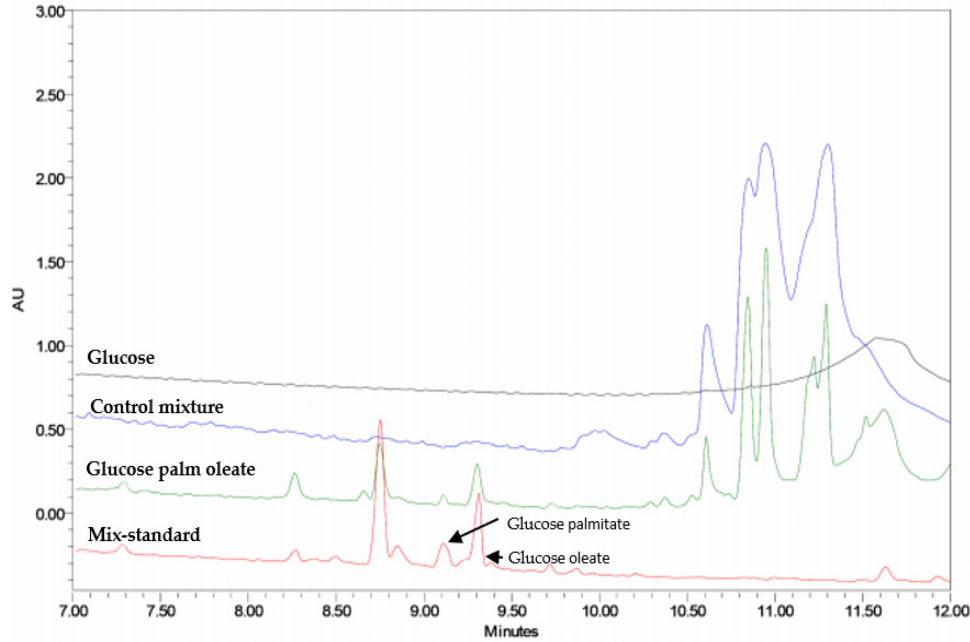
Figure 3. UPLC chromatographic separation of glucose palm oleate.